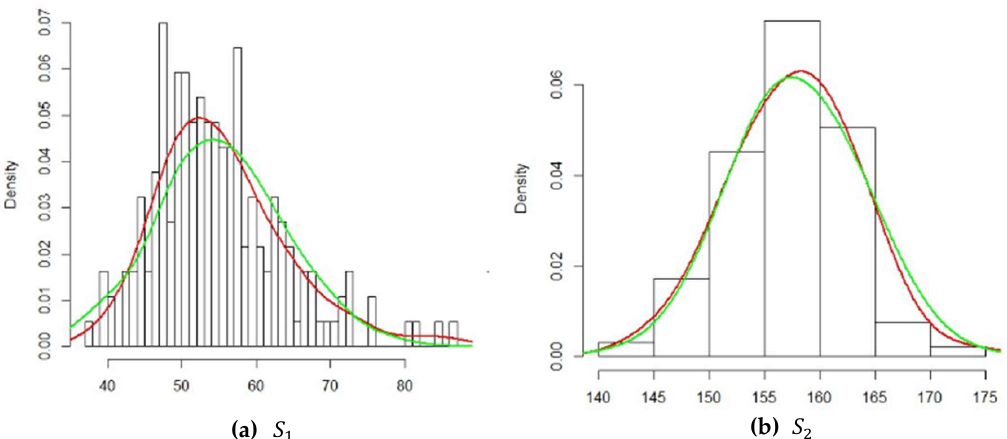
Figure 4. Frequency histograms of non-confidential data with a density curve.